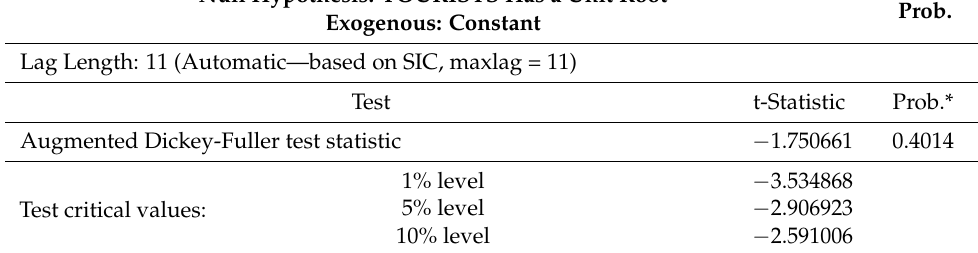
Table 11. Dickey Fuller Test